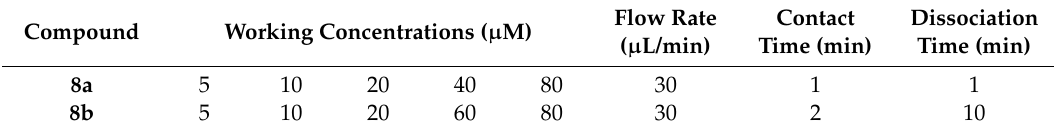
Table 2. Kinetic parameters for Con A–glycopolymer interactions on the Con A